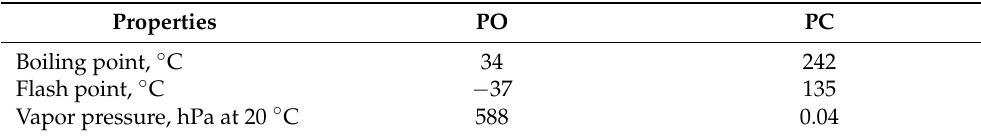
Table 3. Some properties of PO and PC, adapted from